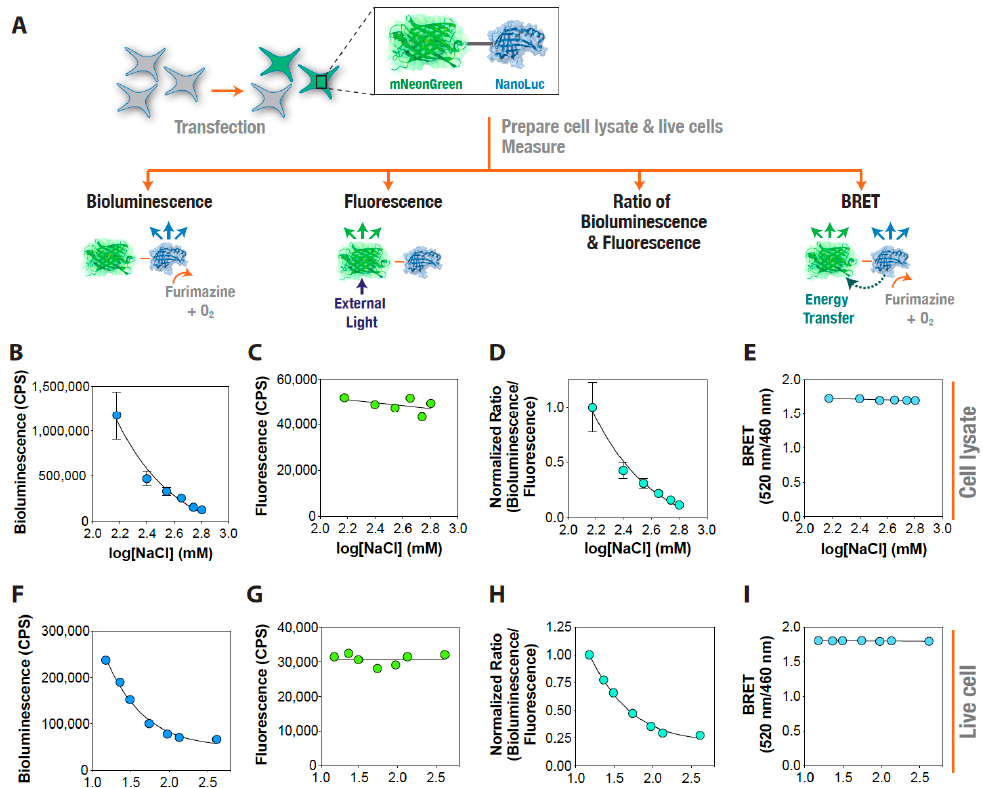
Figure 4. Ionic strength sensing using an mNeonGreen–NanoLuc fusion construct. ( A ) Schematic representation of the experiment showing transfection of cells with mNeonGreen–NanoLuc fusion construct, preparation of cell lysates and live cells, and bioluminescence, independent fluorescence, and BRET measurements. ( B – I ) Graphs showing bioluminescence: ( B , F ) independent mNeonGreen fluorescence; ( C , G ) normalized ratio of bioluminescence and mNeonGreen fluorescence ( D , H ); and BRET (ratio of 520 nm/460 nm emissions) ( E , I ); measured in cell lysates ( B – E ); and live cells ( F – I ) at the indicated NaCl concentrations. Data shown are mean ± standard deviation (SD) of 5 measurements from a representative experiment.